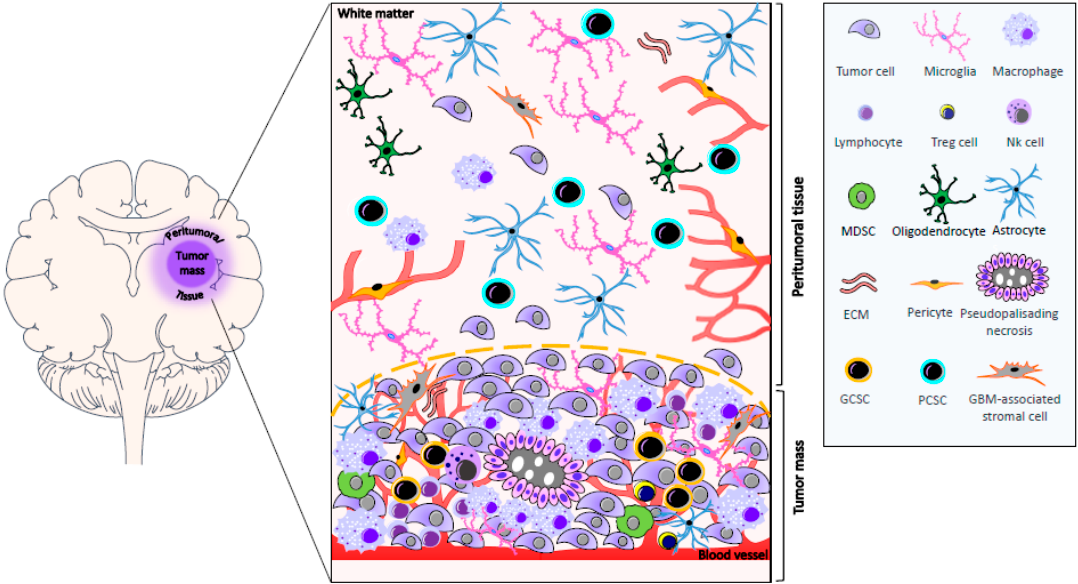
Figure 1. Representation of the main cell populations present in GBM and peritumoral tissue. The tumor mass is characterized by highly proliferating tumor cells, necrosis, and neoangiogenesis. Large areas of necrosis are surrounded by tumor cells arranged in a pseudopalisading pattern. Tumor microenvironment includes ECs and pericytes, reactive astrocytes, GBM-associated stromal cells, extracellular matrix, immune infiltrate of T lymphocytes and Treg cells, myeloid-derived suppressor cells (MDSCs), NK cells, activated resident microglia, peripheral monocyte-derived macrophages, and GBM cancer stem cells (GCSCs). The peritumoral tissue may present tumoral cells and it harbors ECs and pericytes, GBM-associated stromal cells, extracellular matrix, reactive astrocytes, oligodendrocytes, inflammatory cells, and peritumoral tissue cancer stem cells (PCSCs). In addition, persistent neurons are found in the white matter (not shown).